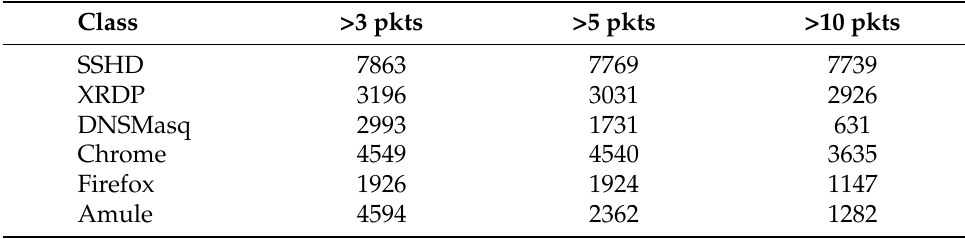
Table 2. UPC data set: number of instances per each